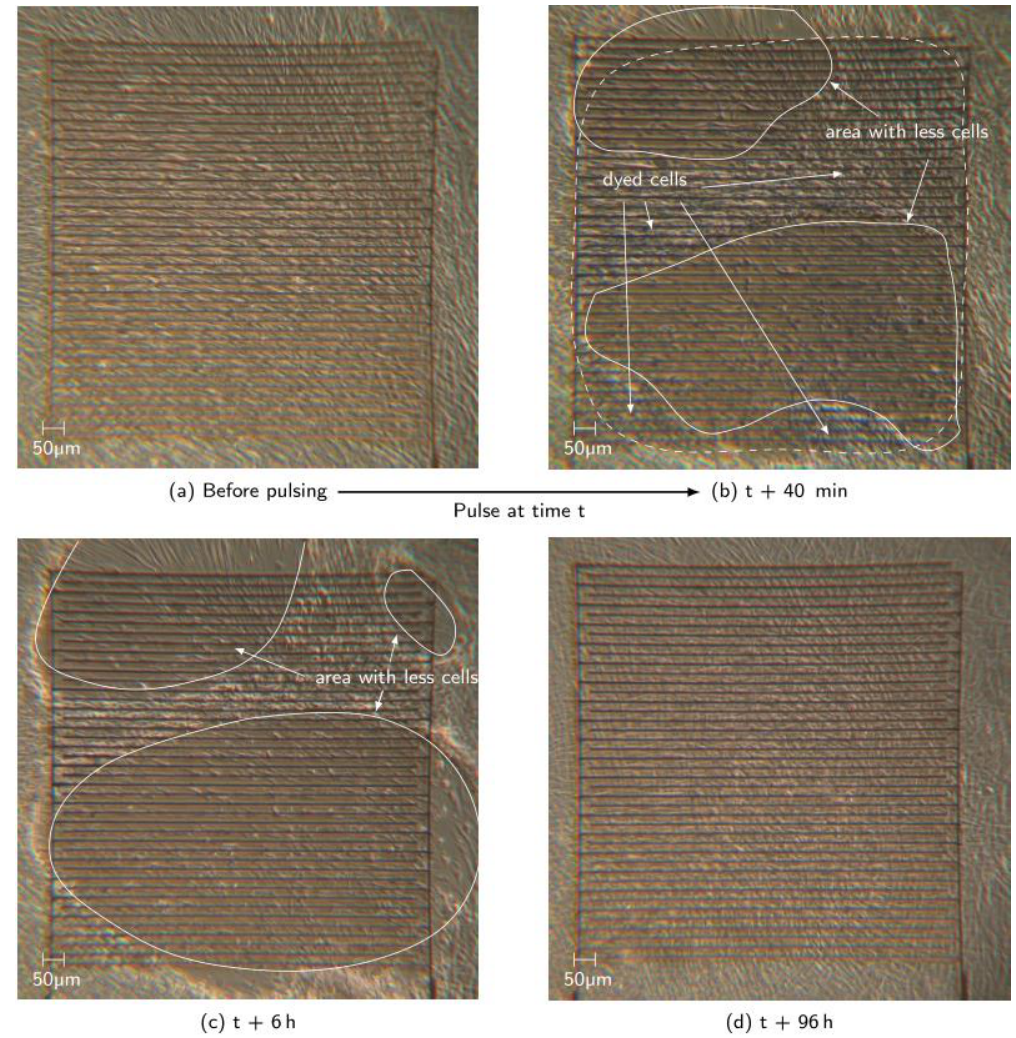
Figure 8. ( a ) Picture of the electrode before nsPEF treatment with vital cells; ( b ) picture of the electrode after trypan blue test; ( c ) increased area with less cells; ( d ) fully recovered cell layer on the electrode 96 h after nsPEF treatment.